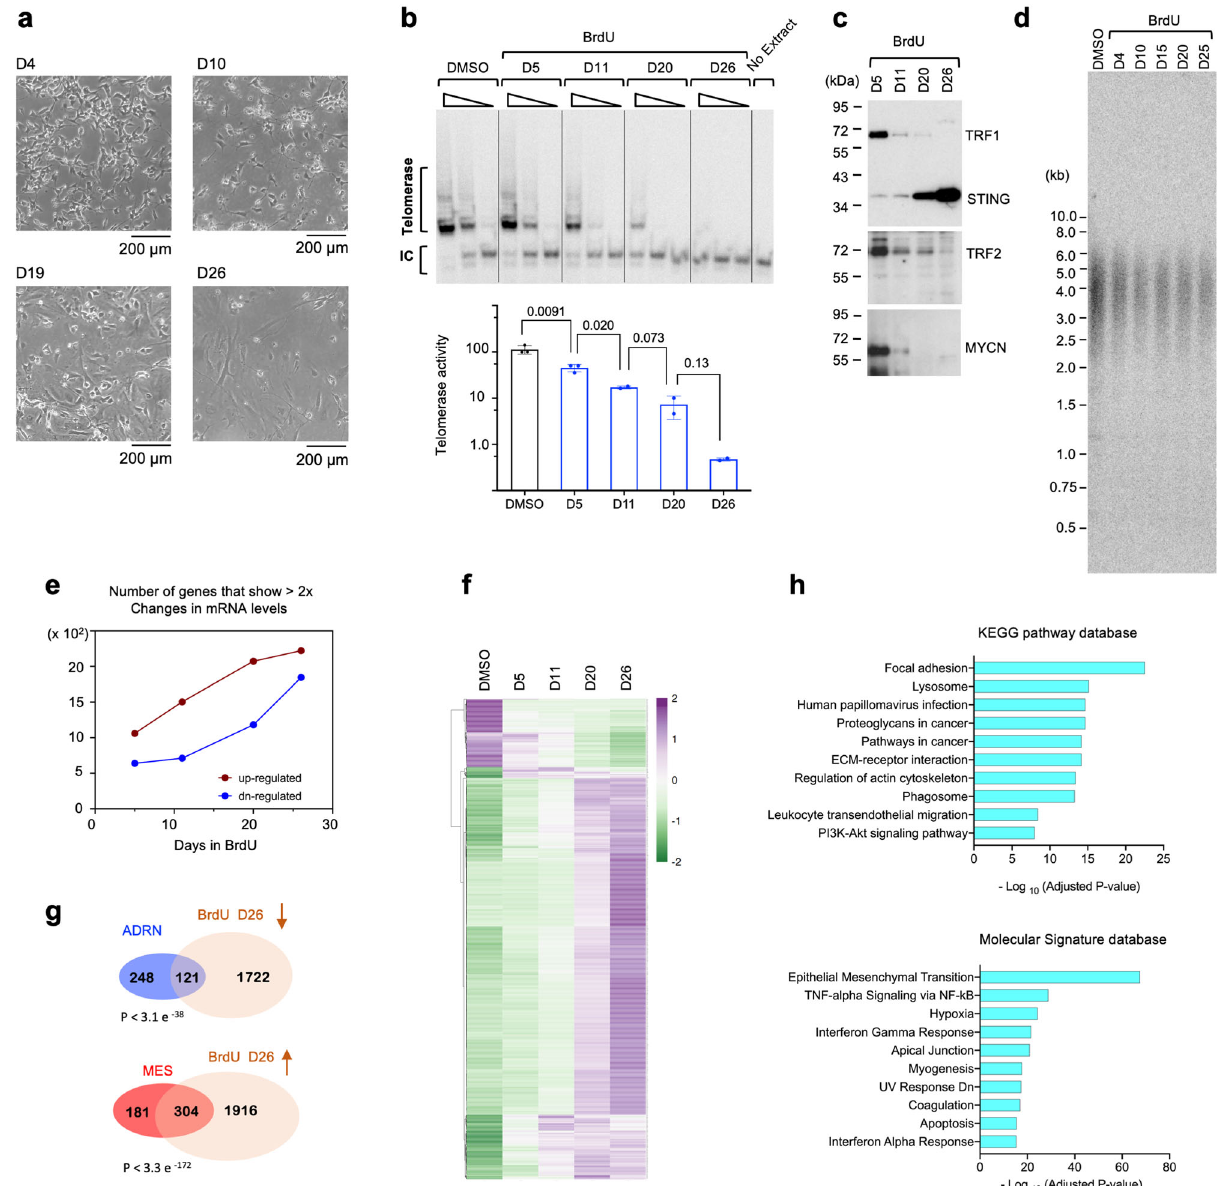
Fig. 3 Pro fi ling of BE(2)N cells during BrdU-induced switch from ADRN to MES cell types. a Morphology of BE(2)N at different time points following BrdU treatment. ( b ) TRAP analysis of telomerase activity in BE(2)N at different time points during BrdU-induced phenotypic switch. The assays were performed using serial dilutions of the extracts (equivalent to 500, 50 and 5 ng of proteins), and the relative activities (mean ± S.D., n = 2 or 3 experimental replicates) are plotted at the bottom. Pair-wise P-values were determined using student ’ s t-tests (two-tailed). c Western analysis of telomere and lineage- related proteins in BE(2)N during BrdU treatment. d Analysis of telomere length distributions in BE(2)N at different time points during BrdU-induced phenotypic switch. e The number of upregulated and downregulated genes in BrdU-treated BE(2)N (by >2-fold in comparison to the DMSO-treated control cells) were determined from RNA-seq analysis and plotted. f The expression patterns of the ~1100 genes that show the greatest changes in mRNA levels (>3 fold) in BrdU-treated BE(2)N were displayed using Heatmap. g The list of genes that were downregulated in BrdU-treated BE(2)N (by >2-fold) was compared to the ADRN signature list 10 . In parallel, the list of genes that were upregulated in BrdU-treated BE(2)N (by >2-fold) was compared to the MES signature. h The ~2000 genes upregulated in BrdU-treated BE(2)N (by >2-fold) were subjected to pathway analysis by the Enrichr program. The top ten GO terms identi fi ed by the KEGG pathway database and the Hallmark gene sets in the Molecular Signature Database were ranked by adjusted P value and